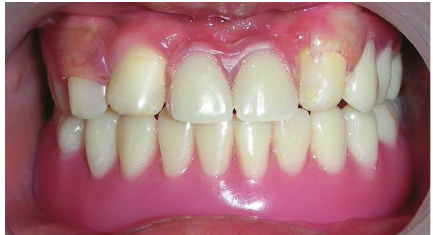
Figure 6: Post insertion Intraoral view.